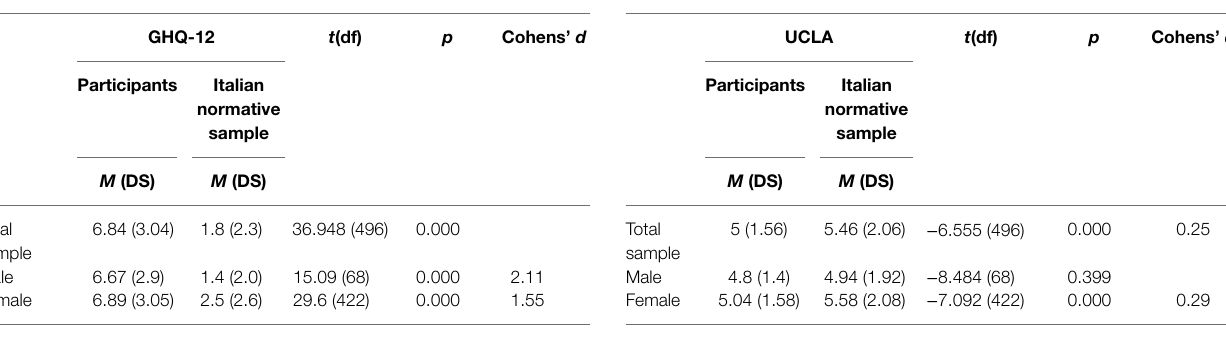
TABLE 3 | Mental health comparison between the average values of the participants and the average values of the Italian normative sample pre-COVID-19 (Preti et al., 2007).